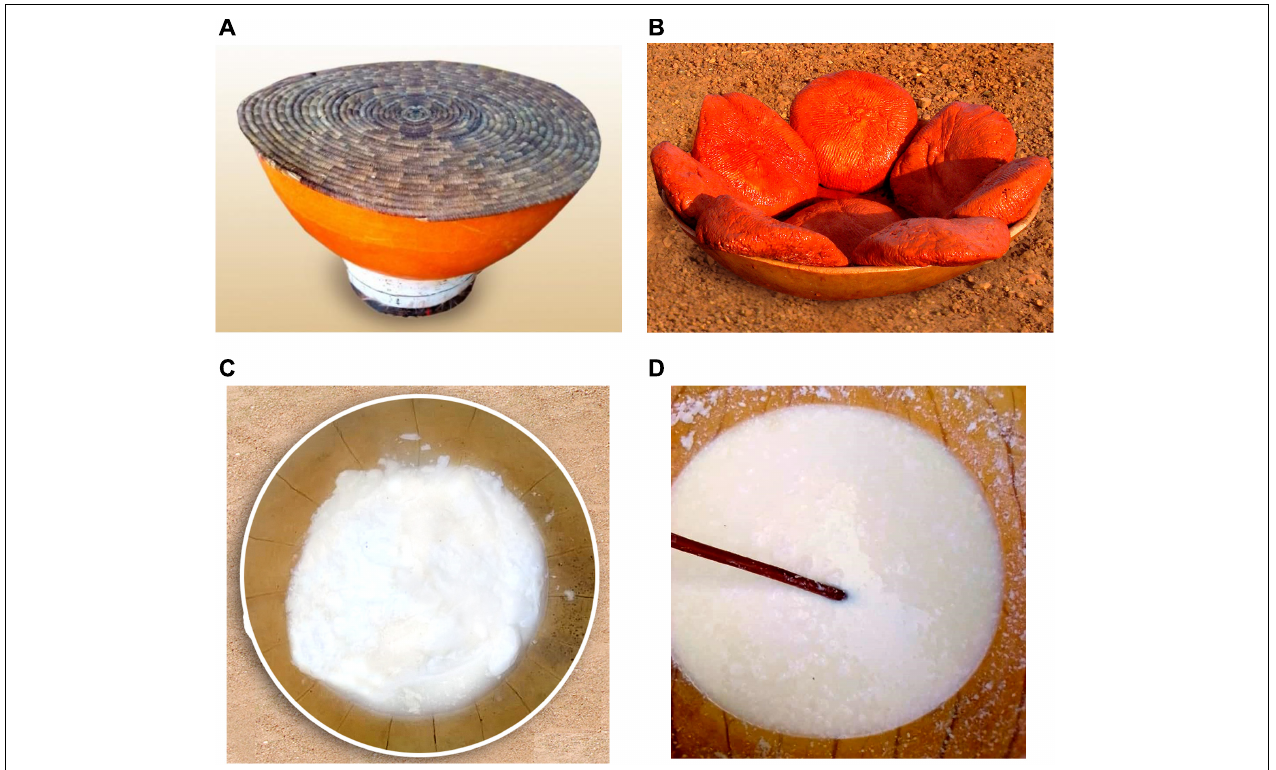
FIGURE 1 | Pictures of the studied dairy products of Benin and Niger. (A) The traditional container used for milk fermentation in Niger, (B) the pink colored Wagashi cheese marketed in Benin, and the naturally fermented milk product of Benin (C) and Niger (D) are shown here. The colored Wagashi cheese is prepared by soaking into a millet leaf brine for the pink color